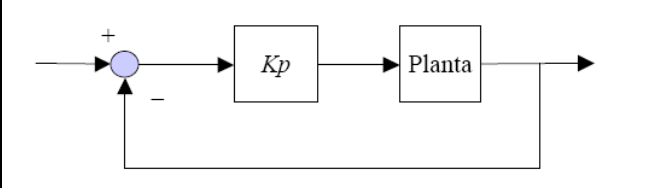
Figura 7: Planta de procesamiento químico de producción de propilenglicol. Fuente: Los Autores, (2018).